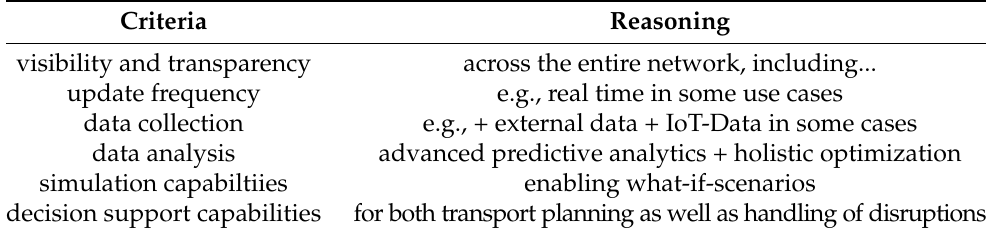
Table 1. Criteria for a solution.